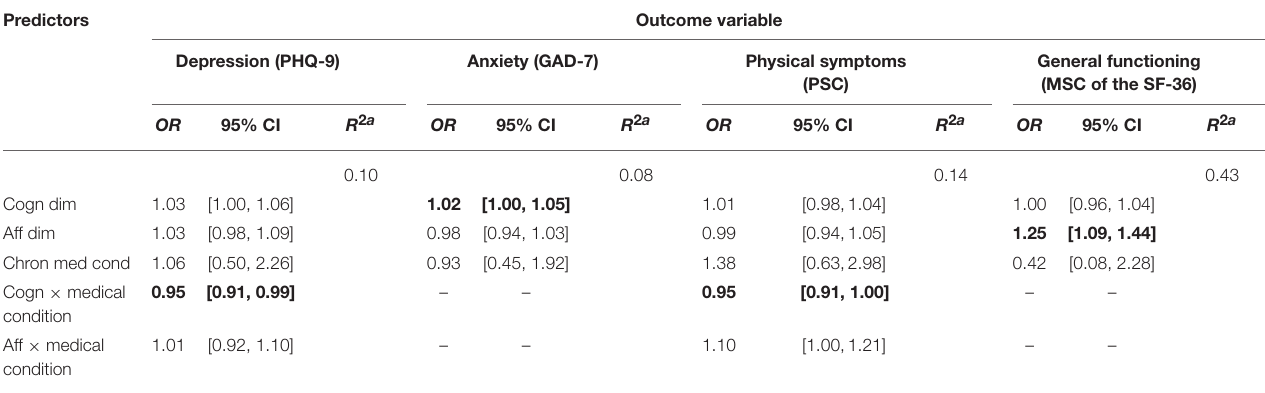
TABLE 4 | Logistic regression analyses predicting reliable change regarding depression, physical symptoms, and general functioning. Predictors